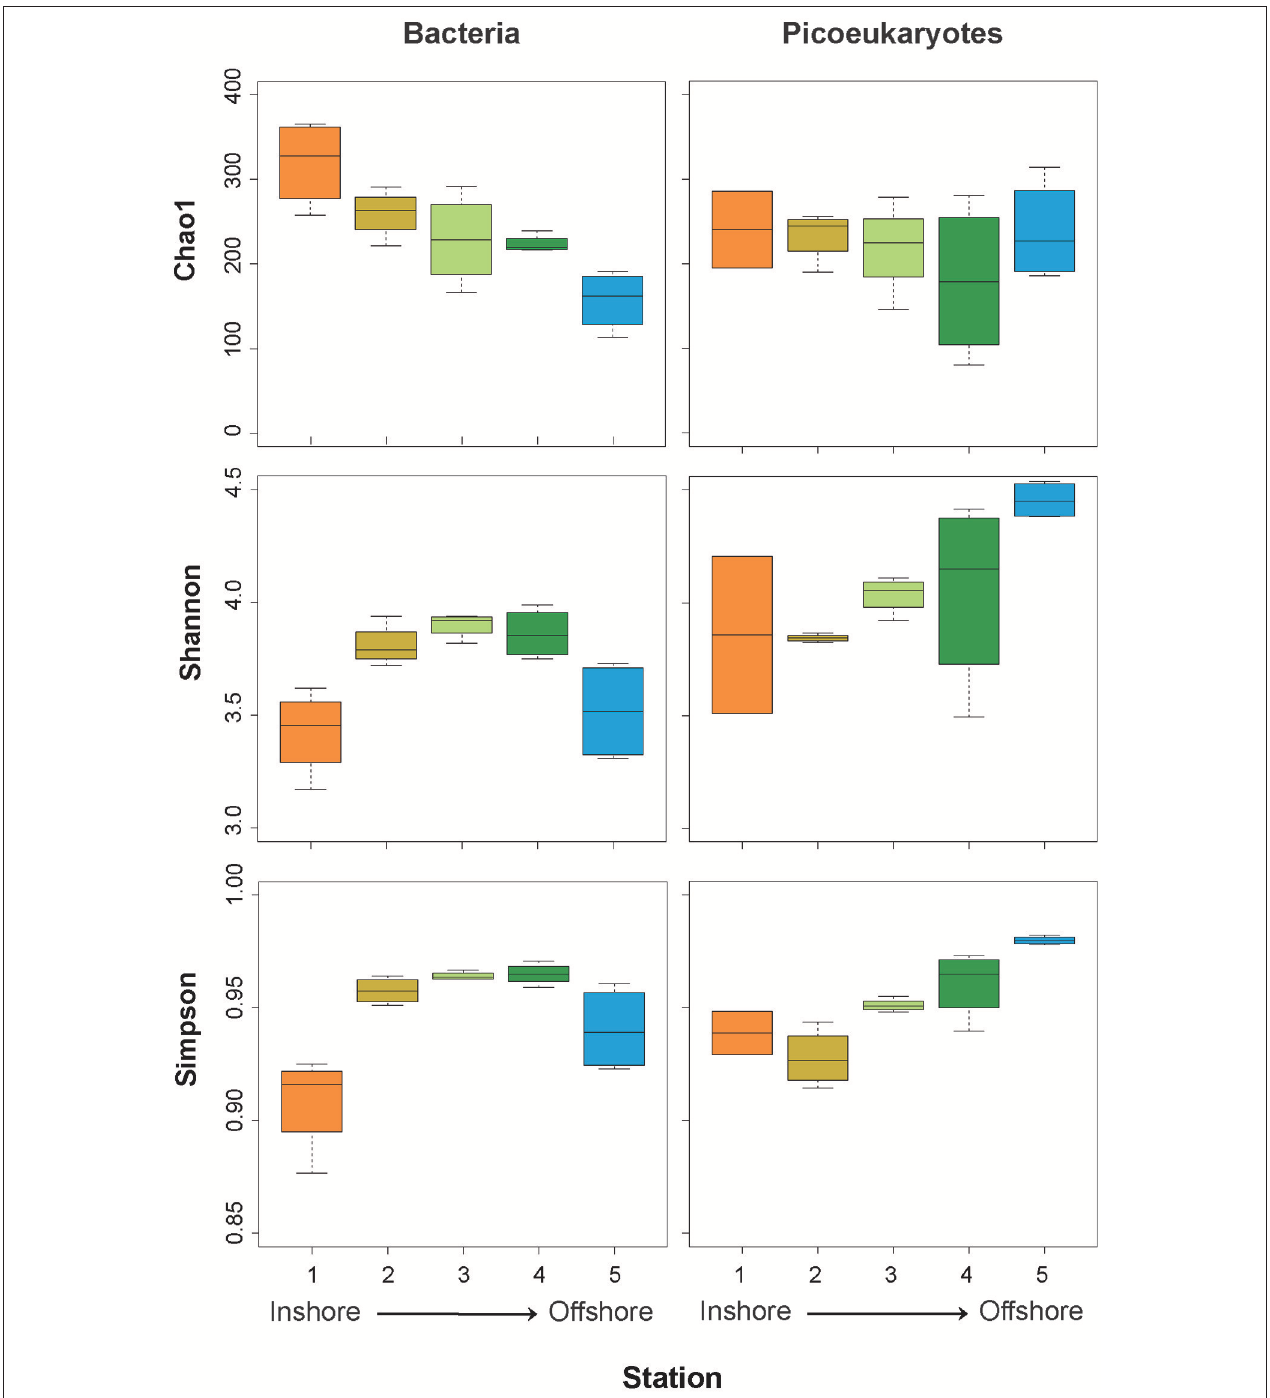
FIGURE 6 | Box plots showing estimates of alphadiversity (Chao1, Simpson, and Shannon indices) from the coastal (Station 1) to the offshore station (Station 5) for bacteria (left panels) and picoeukaryotes (right panels).